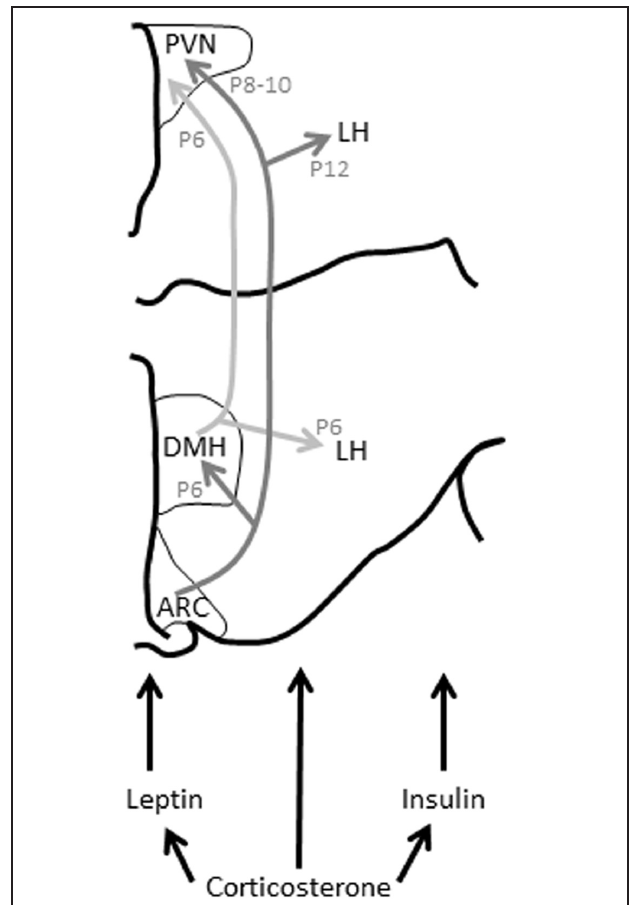
FIGURE 2 | Leptin, insulin, and glucocorticoids modulate hypothalamic connectivity during development. Changes to these hormonal profiles in early life can influence the development of this connectivity and thus feeding behavior and, probably, HPA axis function long-term. ARC, arcuate nucleus of the hypothalamus; DMH, dorsomedial nucleus of the hypothalamus; LH, lateral hypothalamus; P, postnatal day (day by which this connectivity has developed in the rat); PVN, paraventricular nucleus of the hypothalamus. Figure adapted from Bouret and Simerly